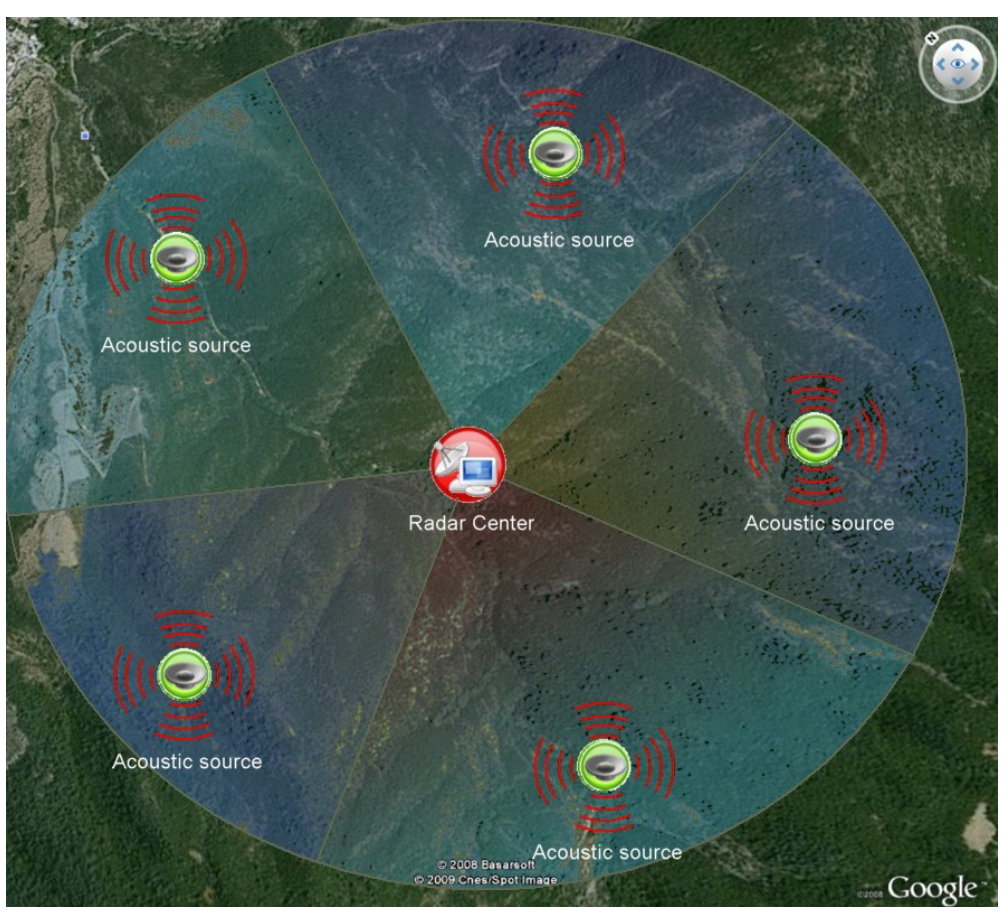
Figure 2. Proposed system